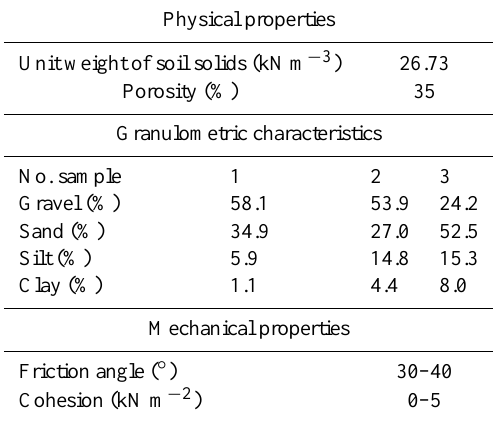
Table 1. Physical and mechanical properties of the colluvial de-